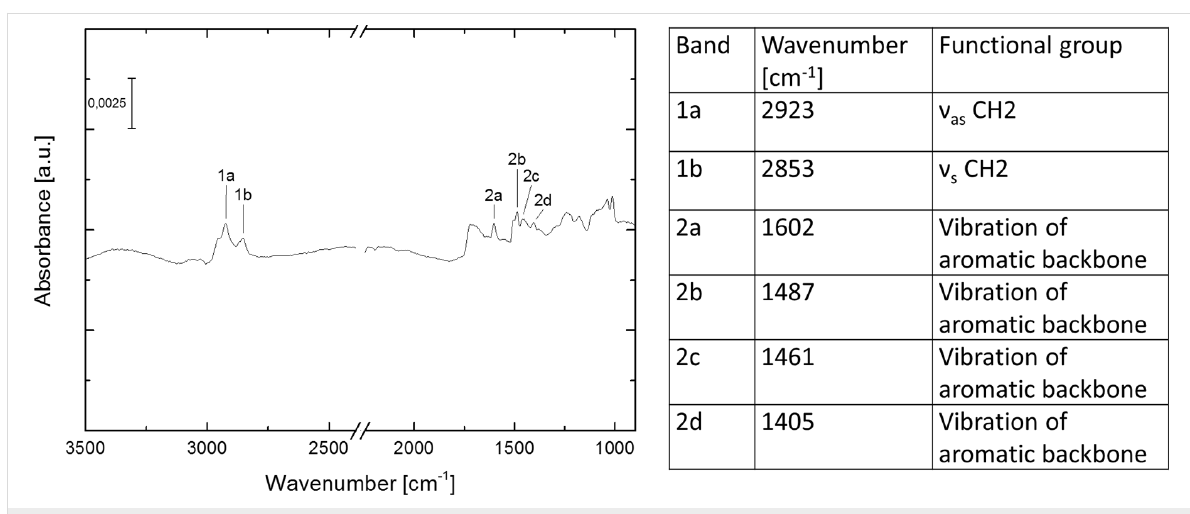
a thickness of roughly 20 nm after 20 reaction cycles. The growth rate of roughly 1 nm per reaction cycle is in the same order as the previously described LbL synthesis of CMP nanomembranes using CuAAC click chemistry